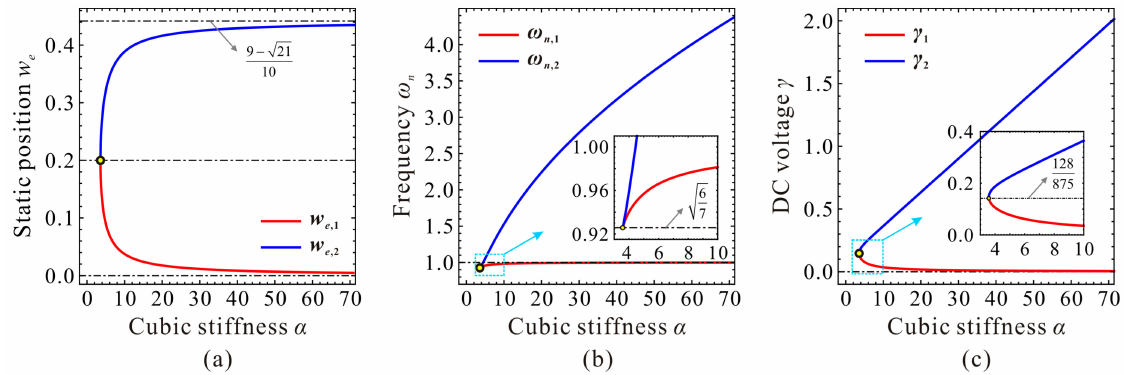
Figure 6. Variations of the nondimensional static position ( a ), fundamental frequency ( b ) and DC voltage ( c ) corresponding to point C 1 and C 2 versus cubic stiffness α